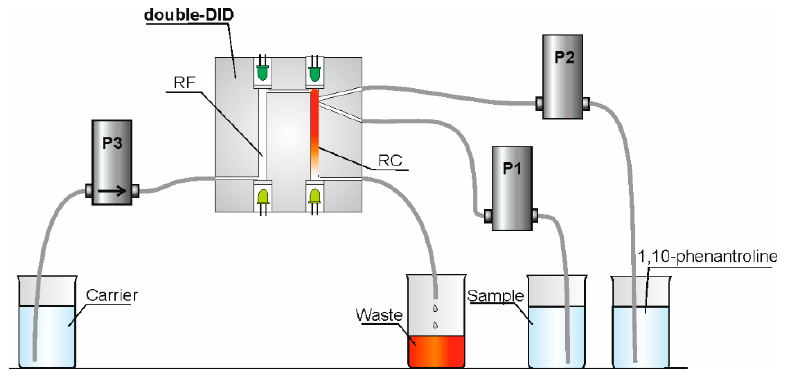
Figure 4. The schematic diagram of the applying flow network. P1, P2, P3, solenoid micro-pumps; RC, reaction chamber; RF, reference chamber.